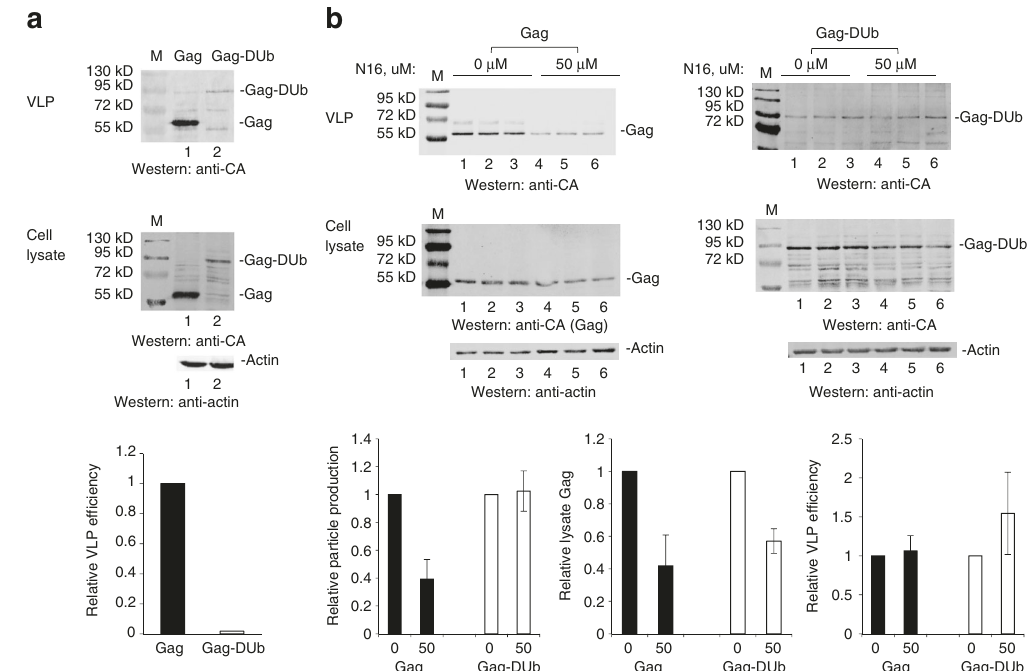
Fig. 3 Gag-DUb fusion budding is resistant to N16 inhibitory effect. a 293T cells were transfected with DNA encoding Gag or Gag-DUb. After 24 h, tissue culture media was removed for VLP isolation and cell lysates were prepared. Top: western blot analysis of Gag in cushioned VLP samples; middle: Gag and actin in cell lysates; bottom: quantitative analysis of VLP release ef fi ciency normalized to the WT Gag control (Gag and Gag-DUb differed in sample size in order to yield visible signal). b Effect of N16 on Gag and Gag DUb VLP production. Top: western blot analysis; Triplicate samples are shown to demonstrate reproducibility. Bottom: Quantitative analysis of VLP production (left), lysate Gag (center) and VLP release ef fi ciency (right) normalized to the mock- treated control. Number of independent assays: n = 3; error bars represent 1 SD for the assay values normalized to 0 µ M